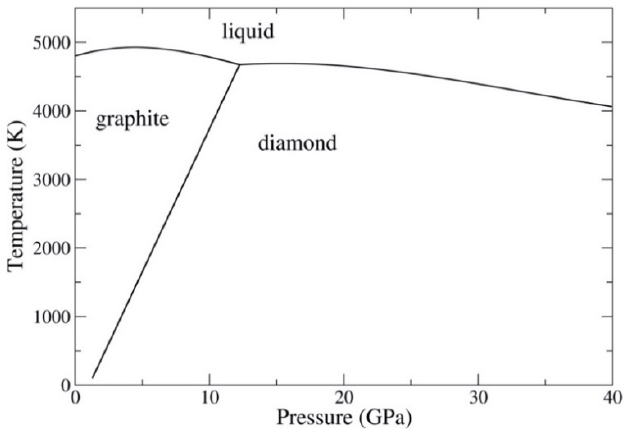
Figure 1. The phase diagram of carbon [4].